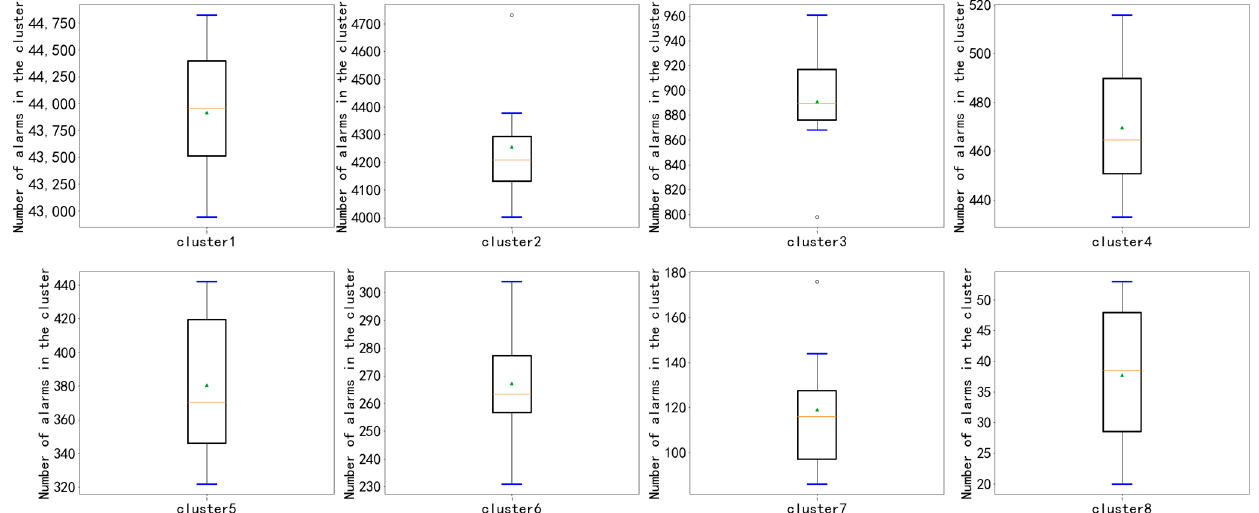
Figure 19. Boxplots of the number of alarms in 8 clusters.